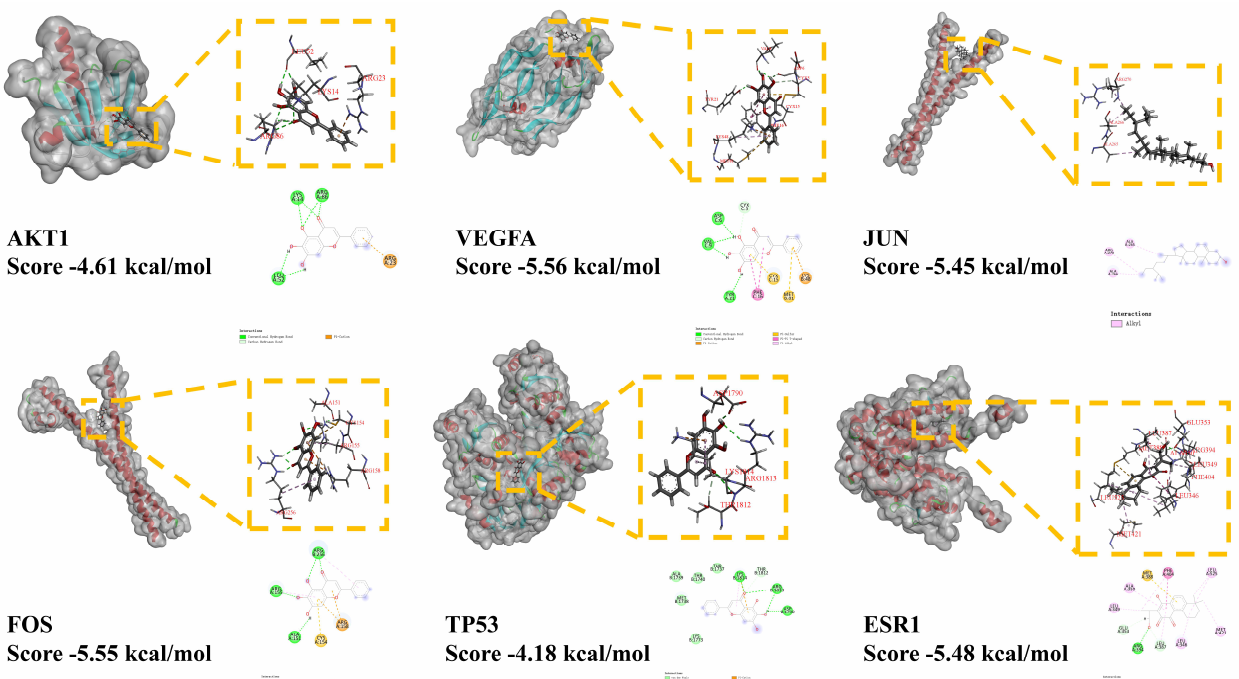
Figure 5. Molecular docking. The figure shows the results of docking with their corresponding effective compounds through the comprehensive ranking of the top 6 proteins, including the three-dimensional conformation of the docking of proteins with effective compounds, the docking score, and the interaction of dimensions.